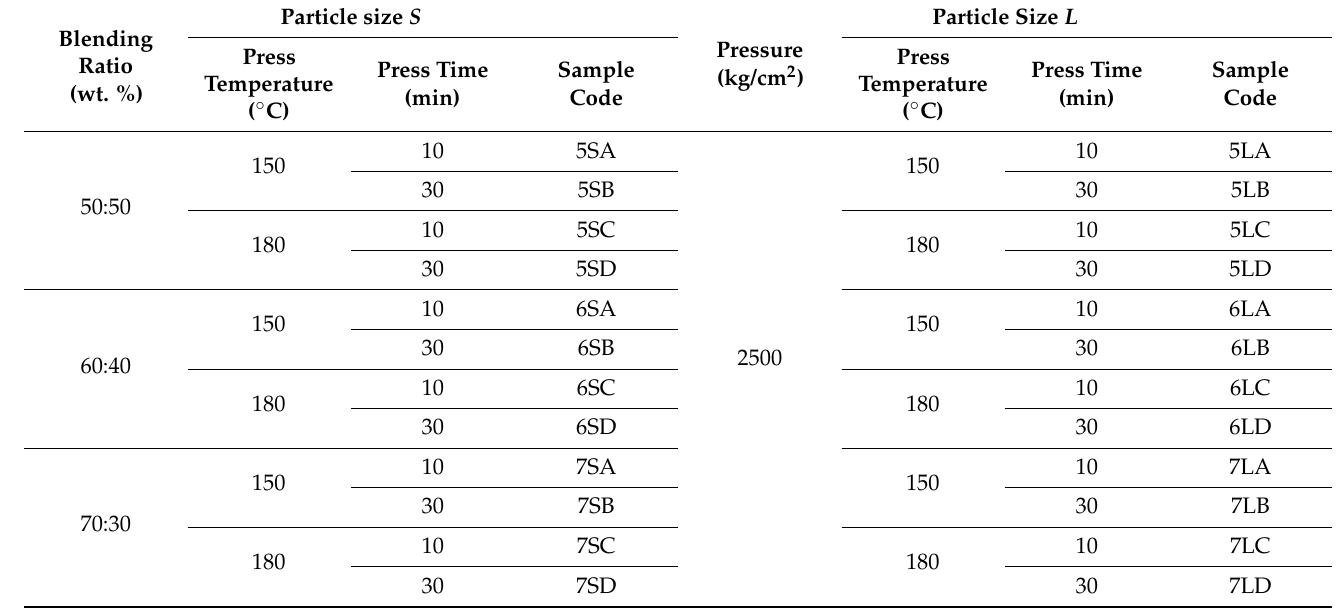
Particle Size L Pressure (kg/cm 2 )